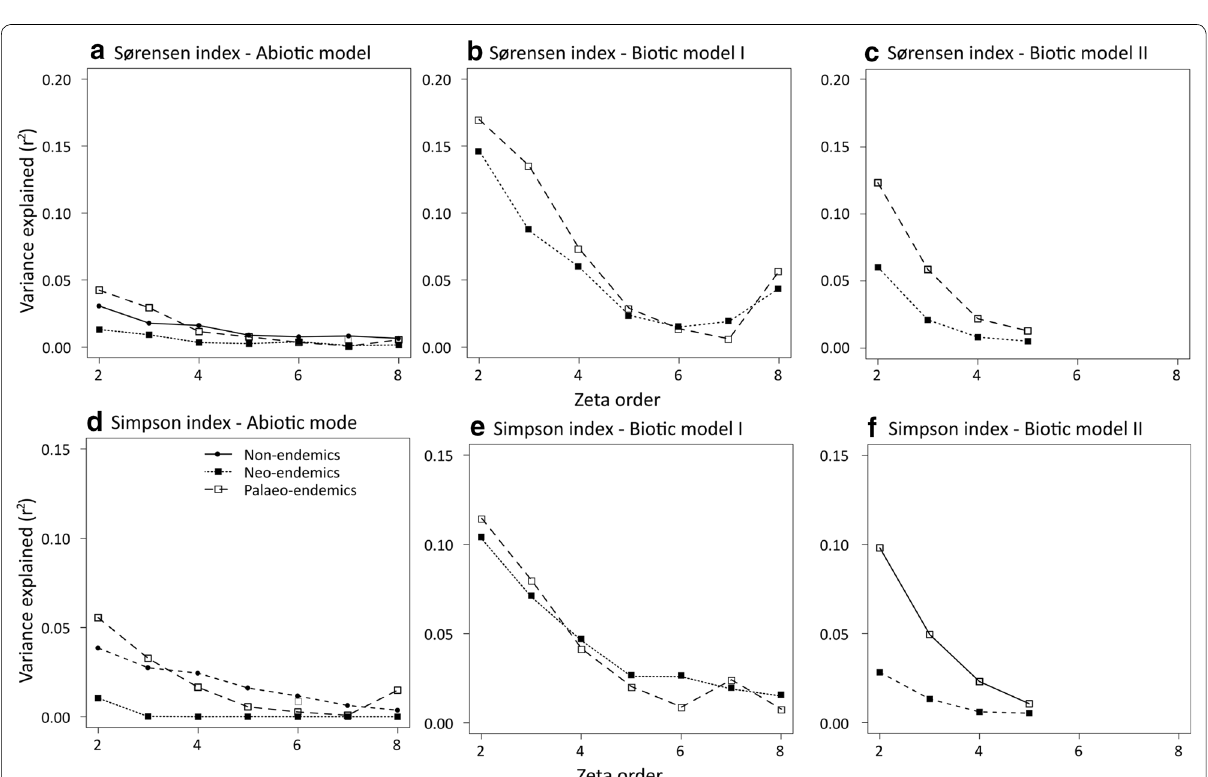
Fig. 2 Variance explained by the abiotic Multi‑Site Generalized Dissimilarity Model predicting Sørensen and Simpson zeta index differences ( a , d ) as function of environmental variables and distance for non‑endemic, neo‑endemic and palaeo‑endemic vascular plants of Crete, Greece, and by the biotic I and II Multi‑Site Generalized Dissimilarity Models for Sørensen ( b , e ) and Simpson ( c , f ) zeta index differences by adding the non‑endemic zeta diversity, and palaeo‑endemic or neo‑endemic zeta diversity as predictors for neo‑endemics and